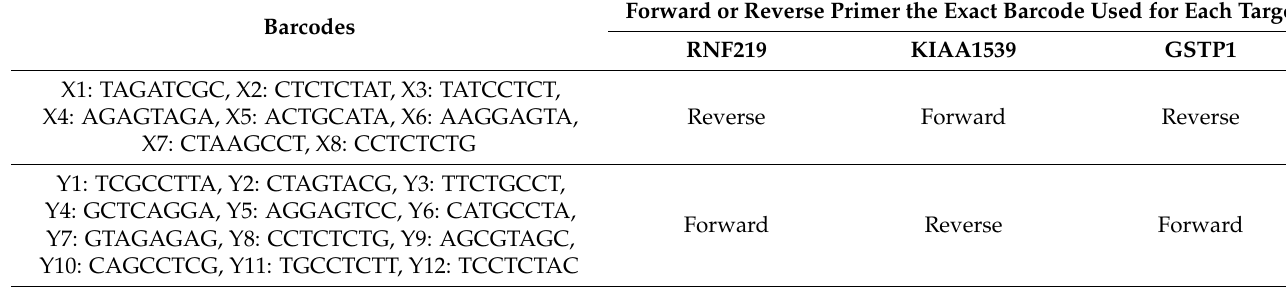
Table 3. Barcodes